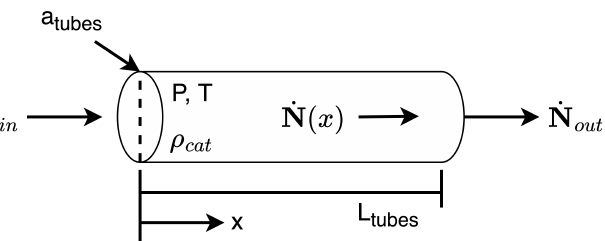
Figure 8. A single tube for a plug flow reactor. a tubes is the single tube area. P and T are the reactor operating pressure and temperature. x is the coordinate along the length of the tube, which has a length of L tubes . ρ cat is the density of the catalyst packed into the reactor tube. ˙ N ( x ) is the molar flow rate along the length of the tube, with subscripts in for the inflow and out for outflow.